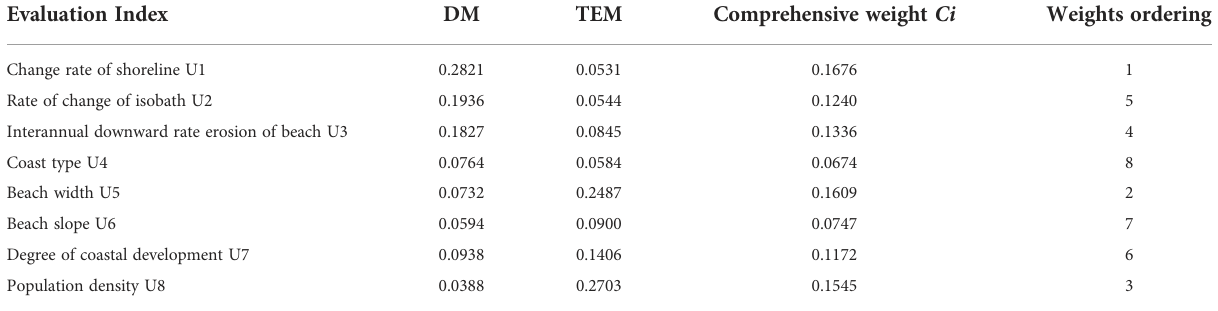
TABLE 2 Index weight value of coastal erosion vulnerability assessment.